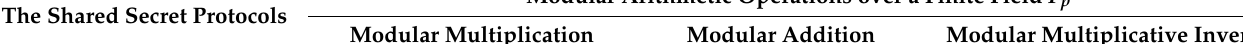
Table 6. The computation cost of share reconstruction for the proposed protocol and some linear shared secret